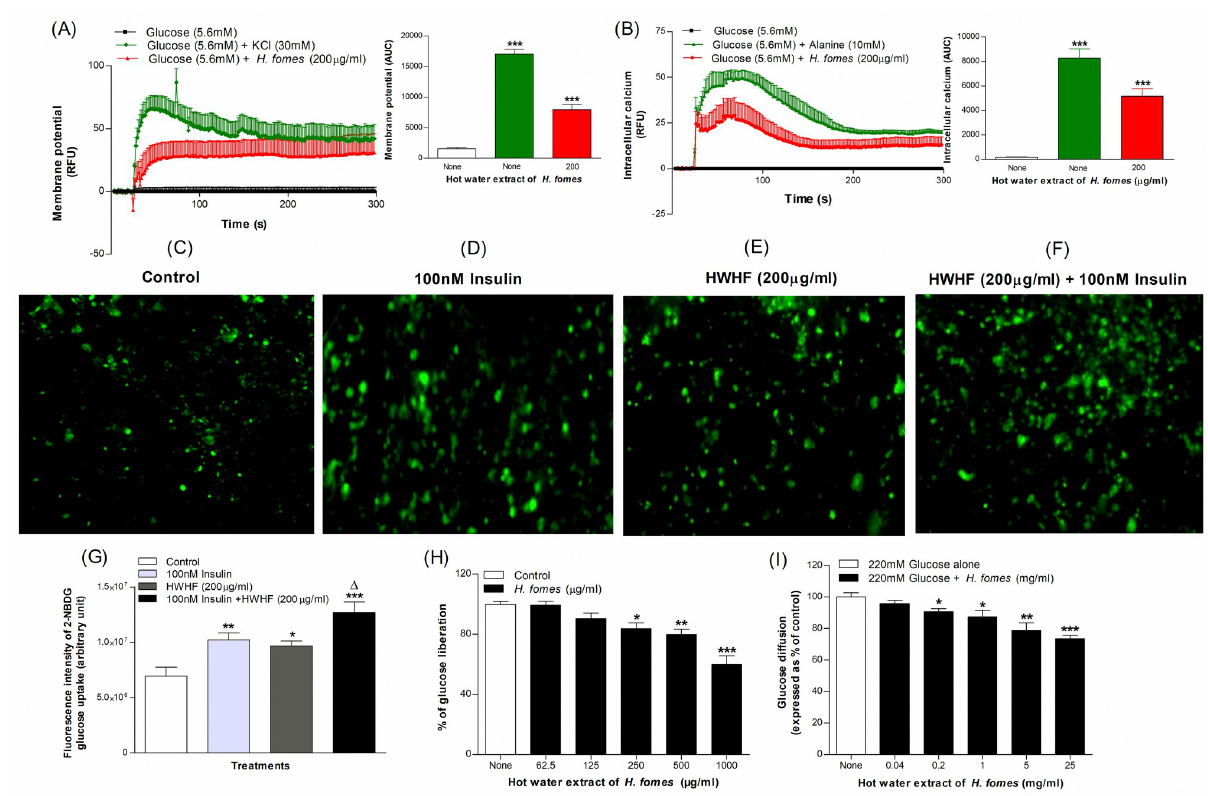
Fig 2. Effects of HWHF on (A) membrane potential and (B) cytoplasmic calcium in BRIN BD11 cells, (C, D, E, F & G) glucose uptake by differentiated 3T3L1 adipocytes, (H) starch digestion and (I) in vitro glucose diffusion. Fluorescence intensity was monitored in cells incubated with HWHF without (E) or with (F) 100 nM insulin. Images are taken at X10 magnification. Values are Mean ± SEM for n = 6 for membrane potential and cytoplasmic calcium, n = 4 for glucose uptake, starch digestion and glucose diffusion. � p < 0.05, �� p < 0.01 and ��� p < 0.001 compared to control.